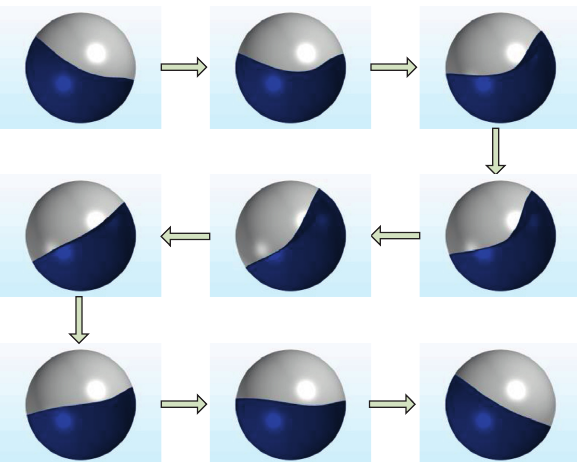
Figure 6: The magnetic fluid level change in a vibration period.